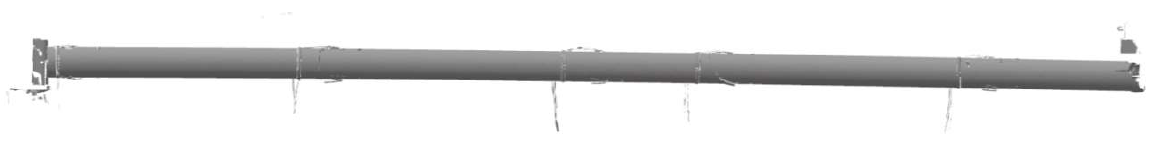
Figure 15. Point cloud of the scanned pipeline in a bent state.